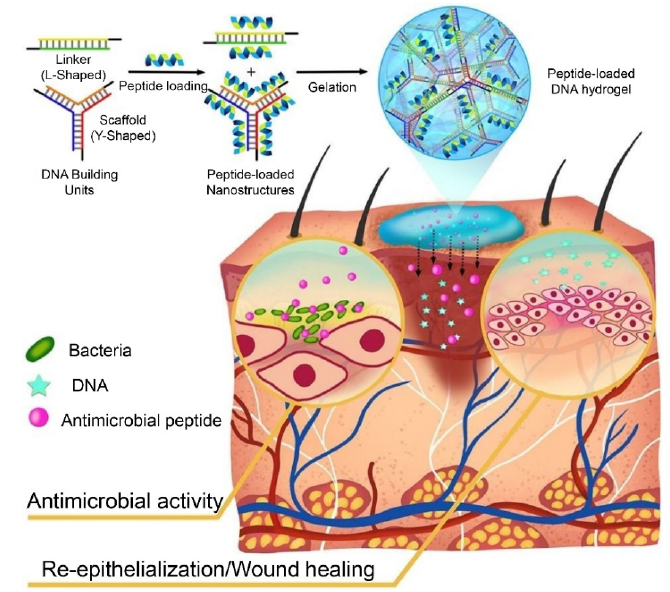
Figure 5. DNA hydrogels deliver antimicrobial peptides in response to pathogenic bacterial infec- tions. (Adapted with permission from [62]. Copyright (2019) Elsevier.)